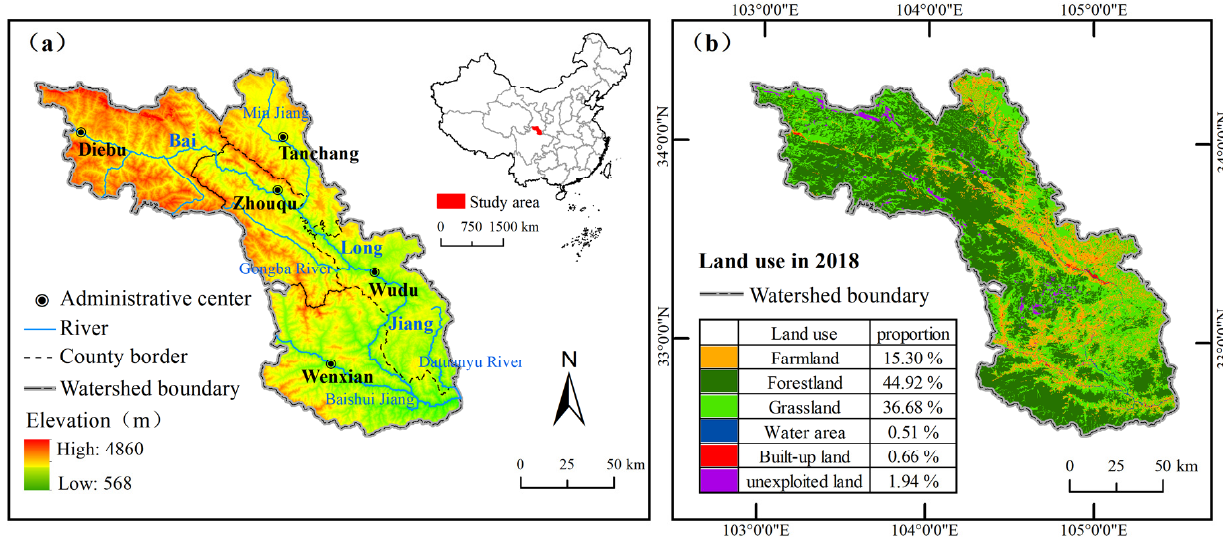
Figure 1. The position ( a ) and land use ( b ) of study area.